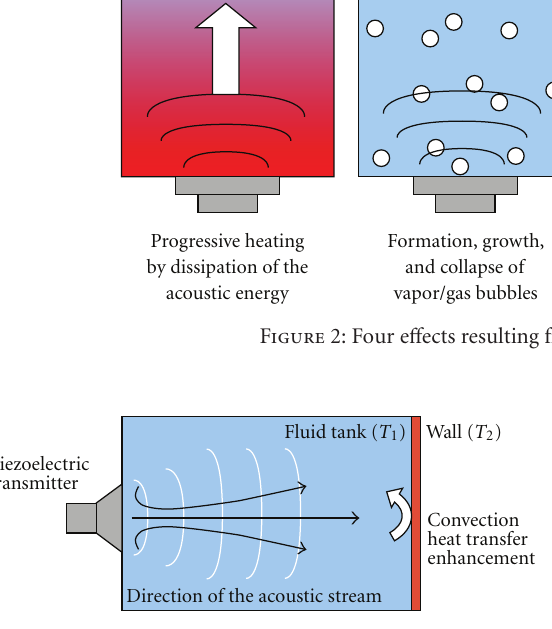
Figure 3: Acoustic streaming—enhancement of convection heat